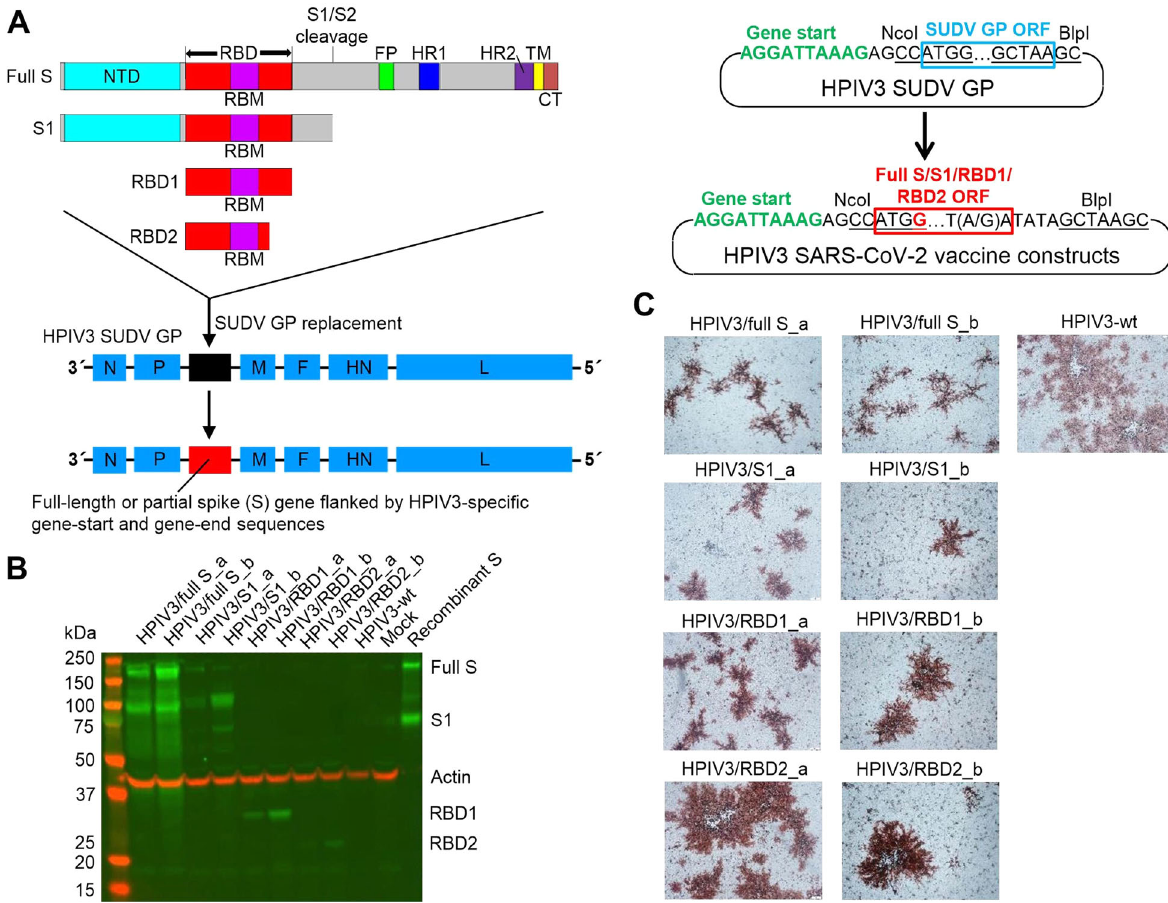
Fig. 1 Recovery and characterization of HPIV3-vectored vaccines expressing SARS-CoV-2 S proteins. A Generation of vaccine constructs. The schematic domain organization of the S inserts (full S, S1, RBD1, RBD2) is shown. NTD N-terminal domain, RBD receptor-binding domain, RBM receptor-binding motif, FP fusion peptide, HR1 heptad repeat 1, HR2 heptad repeat 2, TM transmembrane domain, CT cytoplasmic tail. HPIV3 proteins: N nucleocapsid protein, P phosphoprotein, M matrix protein, F fusion protein, HN hemagglutinin-neuraminidase, L RNA polymerase. B LLC-MK2 cell monolayers were infected for 48 h, lysed, separated on a Western blot and stained for S proteins. Positive control: the recombinant S protein; loading control: actin. C Viral plaques immunostained with rabbit polyclonal antibodies against HPIV3 in LLC-MK2 cells (8